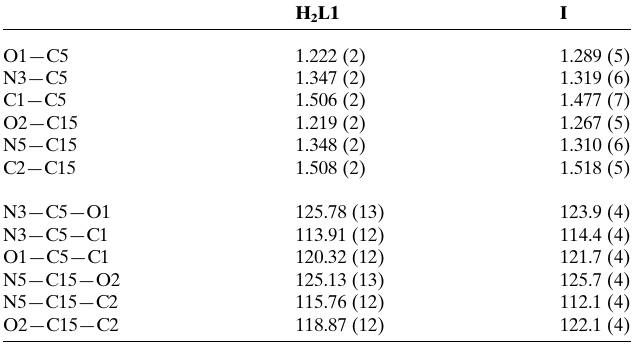
Table 2 A comparison of bond lengths and angles (A˚ , (cid:2) ) in the carboxamide units of H 2 L1 and I .